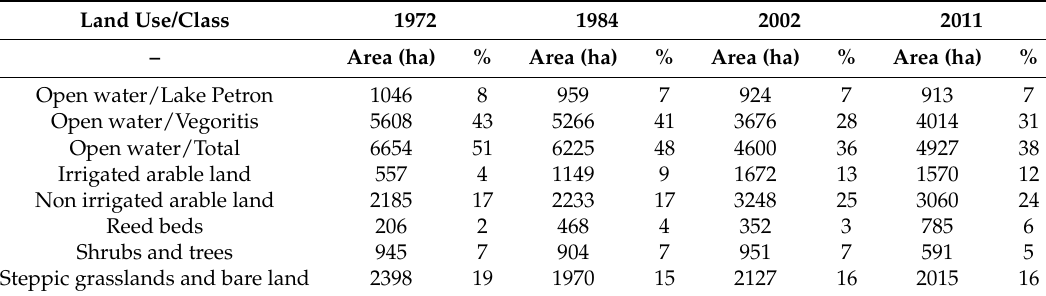
Figure 4. Land cover/land use maps of the studied area for the four point time series (1972, 1984, 2002, and 2011). Table 4. Area extent (ha and %) of the land cover/land use classes as derived from the classification of the satellite images.